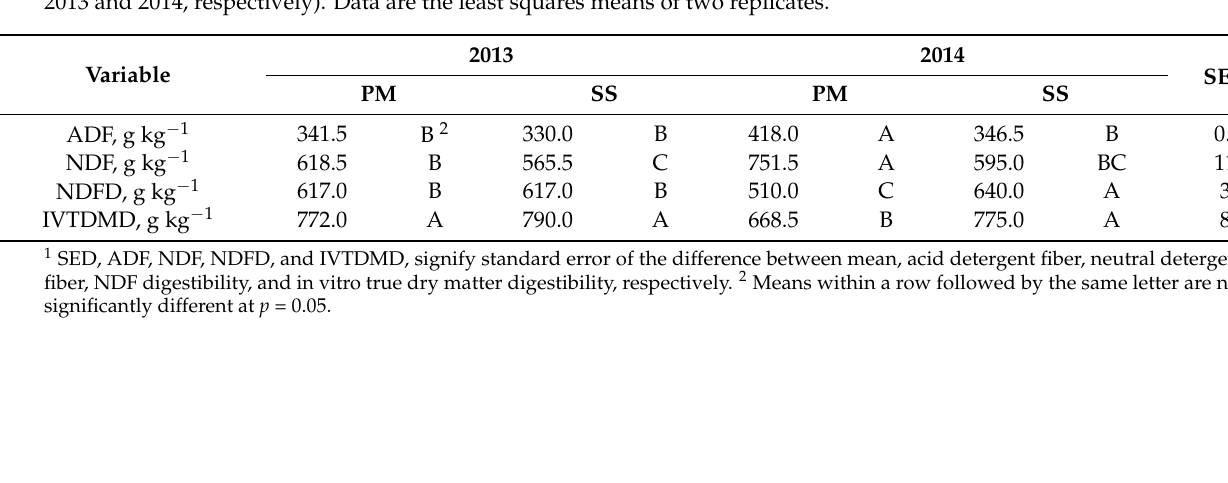
Table 2. The influence of year and forage species on forage fiber and digestibility of freeze-killed pearl millet (PM) and sorghum–sudangrass (SS) from a single cutting at Tucumcari, NM USA in 2013 and 2014 (130 and 140 days after planting in 2013 and 2014, respectively). Data are the least squares means of two replicates.